Question: Sum up the contents of this chart in one sentence.
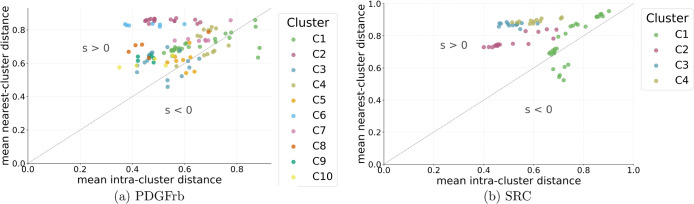
Answer: Scatter plot of mean intracluster distance versus mean nearest-cluster distance for the SRC and PDGFrb data sets. Each data point represents a molecule, colored by the cluster assignment of the expert clustering. Distances are computed as 1 - Tanimoto similarity using Morgan fingerprints with radius 4 and 1024 bits. A silhouette of s < 0 indicates that molecules are closer to a neighboring cluster than to their own.